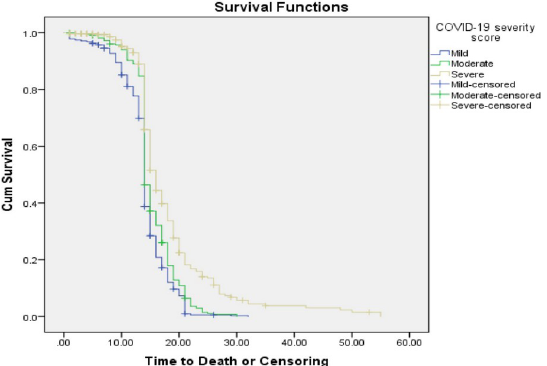
Fig 2. Kaplan-Meier survival analysis of recovery time stratified by COVID-19 clinical category/severity.